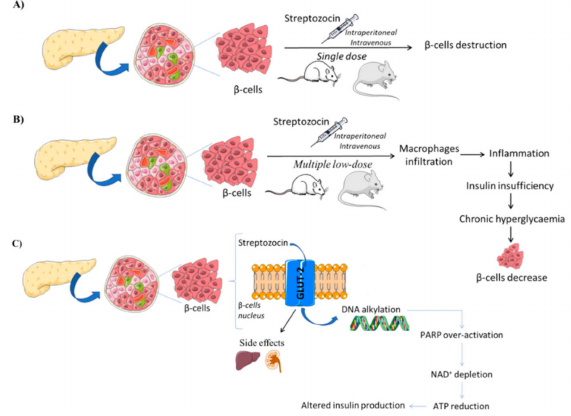
Figure 1. Streptozocin diabetes induction model (based on [17]). ( A ) Single-dose Streptozocin, ( B ) Multiple-low dose streptozocin, ( C ) Streptozocin mechanism on the β -cells nucleus and side effects in other organs with glucose transporter subtype 2 (GLUT-2) receptors. Streptozotocin (STZ) behaves as a glucose analogue and is transported into the pancreatic β -cell by GLUT-2. It produced DNA alkylation and over-activation of poly-ADP ribose polymerase (PARP) causing NAD + depletion, cellular ATP reduction, and compromising